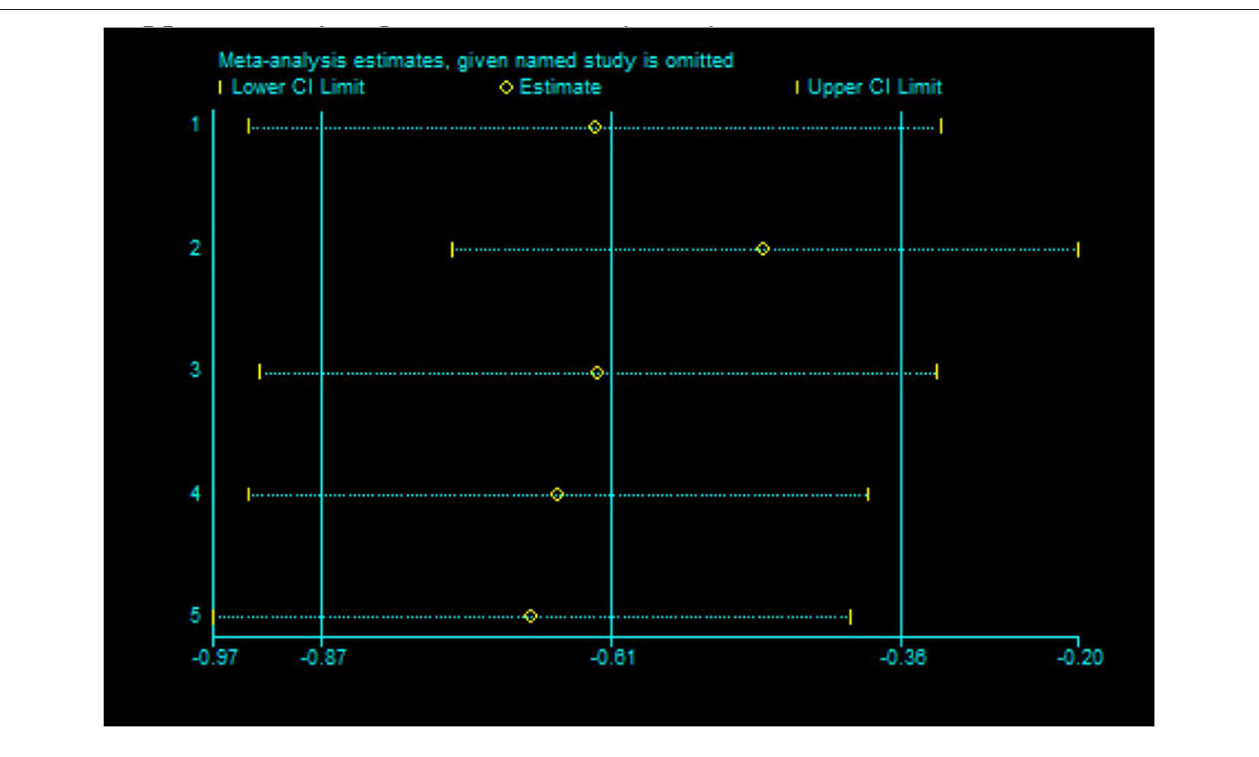
FIGURE 7 | Sensitivity analysis of 5 items to the effect of anxiety.